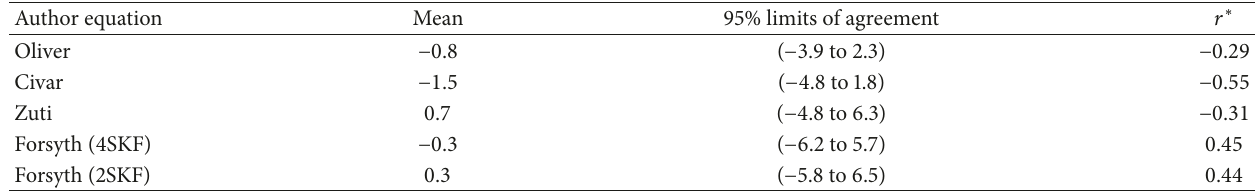
Table 5: Body fat percentage differences (equation − DXA) from anthropometric equations (developed in athletic populations) statistically similar to DXA.